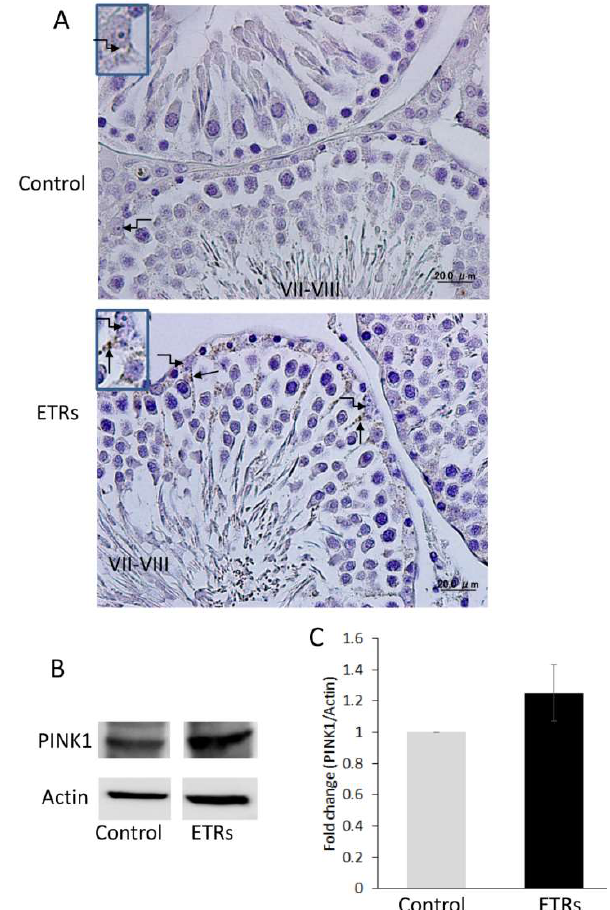
Figure 7. Overexpression of PINK1 in SCs of ETRs indicating mitochondrial damage. ( A ) IHC of PINK1. Note the perinuclear localization of PINK1 (arrows). The broken arrows indicate SC nuclei. The inset shows magnified SC nuclei; ( B , C ) Western blot analysis of PINK1. The relative expression level for protein was normalized to actin and expressed as fold change relative to the control ( n = 3).